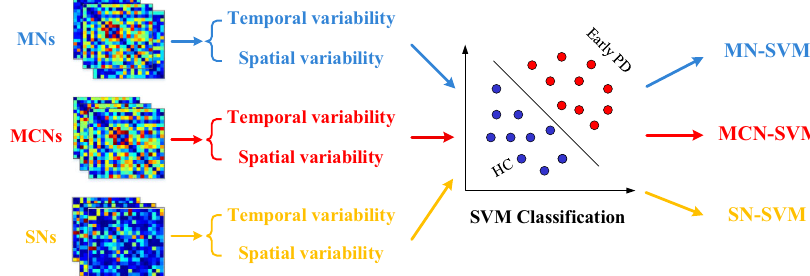
Fig. 8 Features calculated by different methods are taken in a common SVM classi fi er for disease classi fi